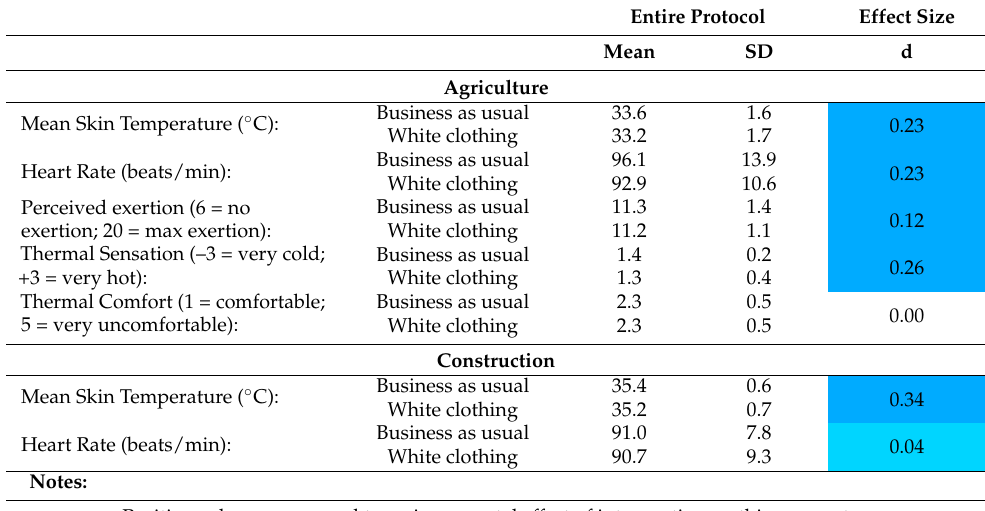
Table A8. Differences in workers’ physiological responses between “business as usual” and “white clothing”